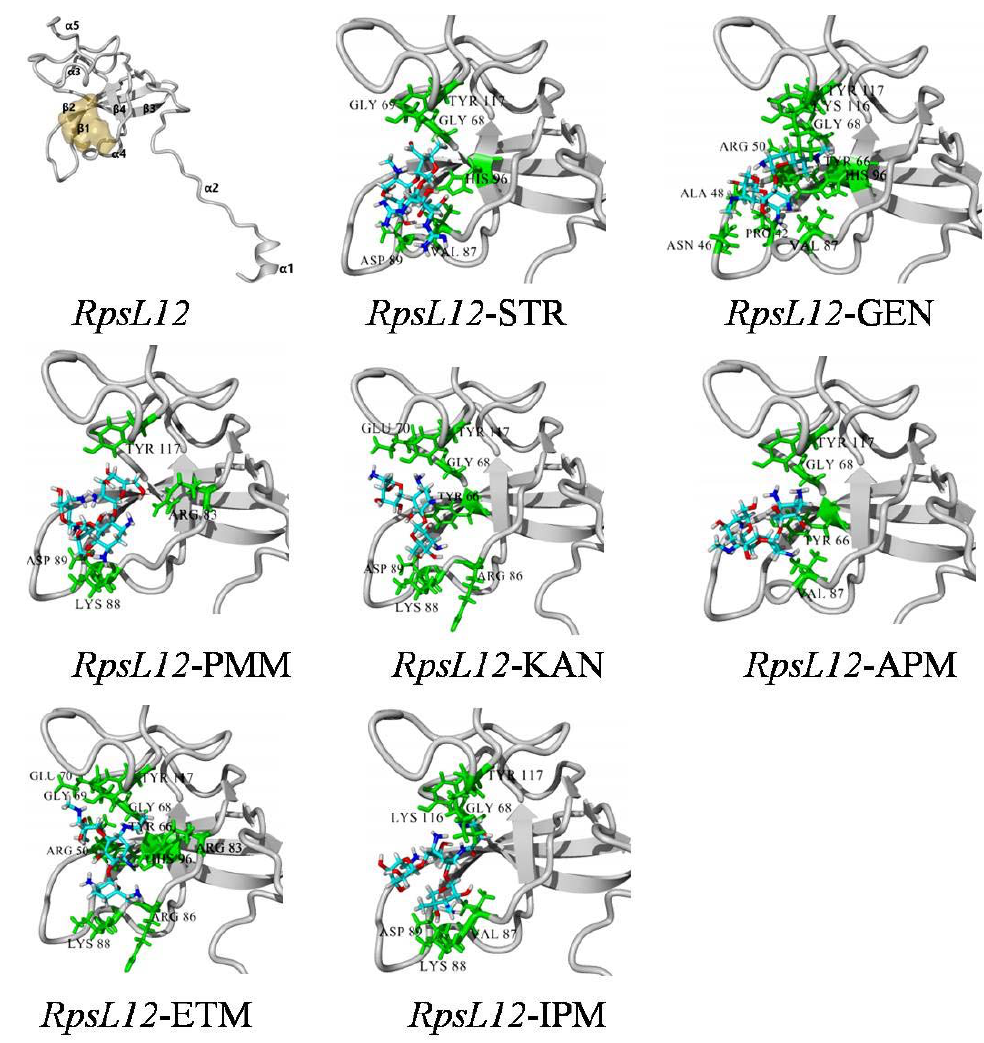
Figure 4. Homological model of the E. coli RpsL12 and its binding complexes with AGs. Table 1. Results of molecular docking, affinity, and sensitivity for the 7 AGs.